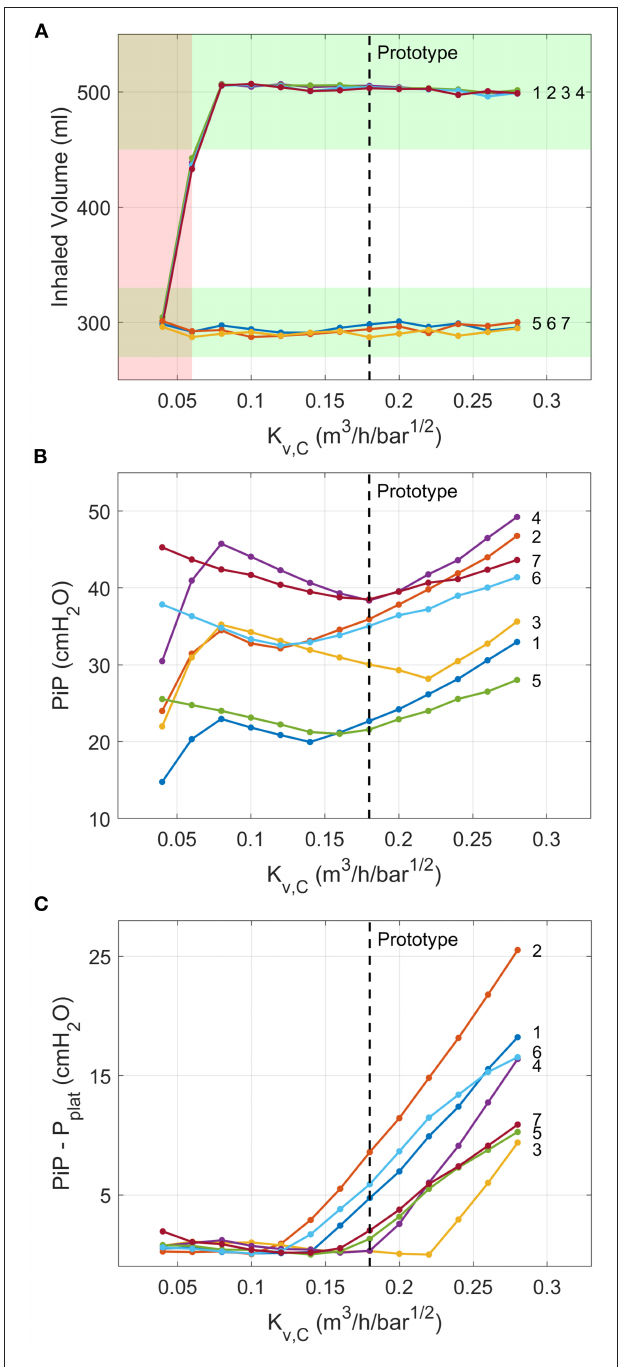
FIGURE 11 | Numerical model predictions of the variations in critical outputs of the inspiration pathway with the flow coefficient of Valve C. Ventilation conditions are labelled by their numbers according to the ISO 80601-2-12:2020 test requirements ( Table 2 ). (A) Tidal volume, with the ISO requirement of being within 10% of the target values shaded green and ranges of K v , C that fail to meet ISO specifications shaded red. (B) PiP, and (C) difference between PiP and p plat . Vertical dashed lines indicate flow coefficient of valve used in the